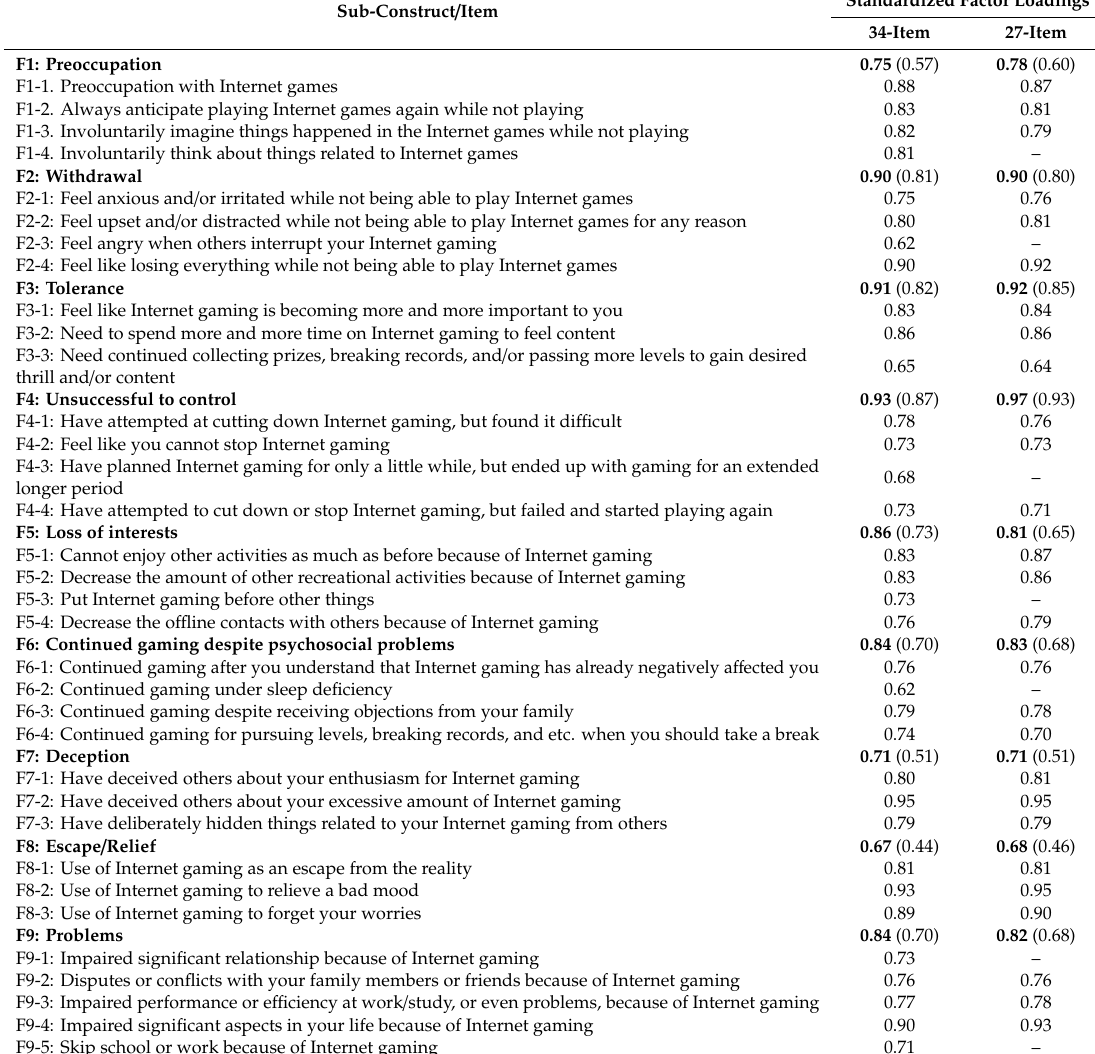
Table 1. Confirmatory factor analysis results of two versions of the Chinese Internet Gaming Disorder Checklist (C-IGDC) ( N = 464).